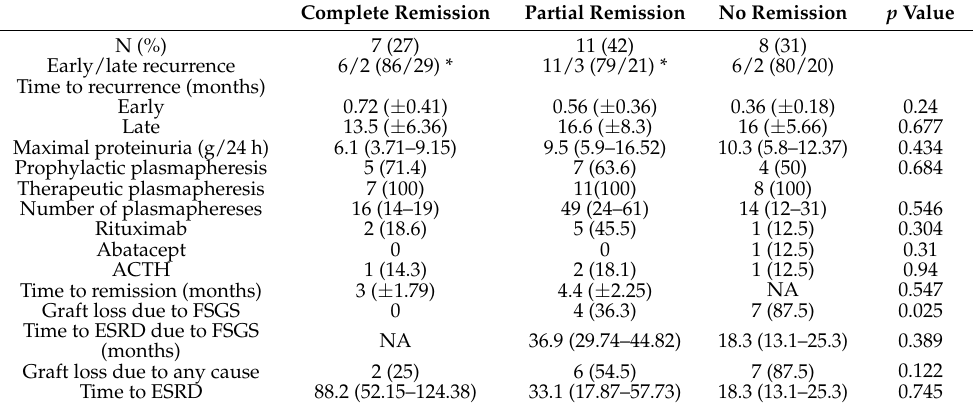
Table 2. Outcomes of patients with FSGS recurrence in the graft following immunosuppressive